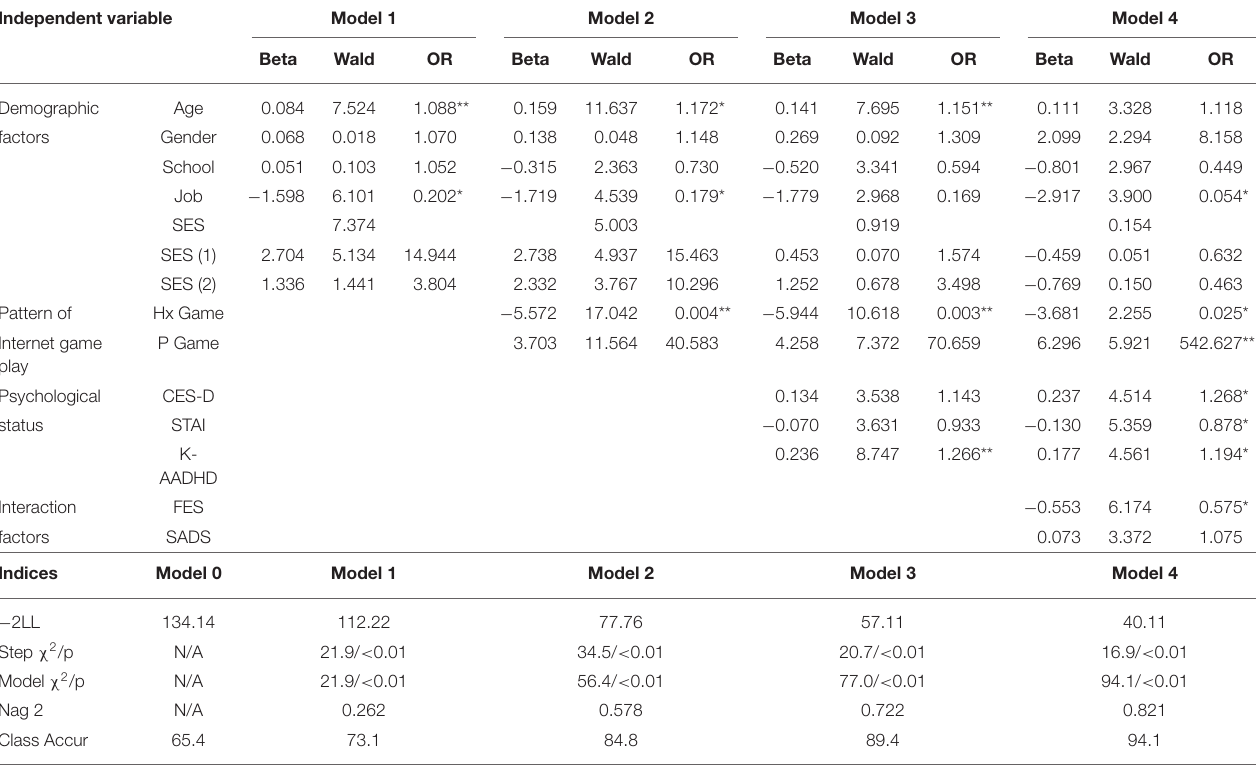
TABLE 3 | Results of the hierarchical logistic regression